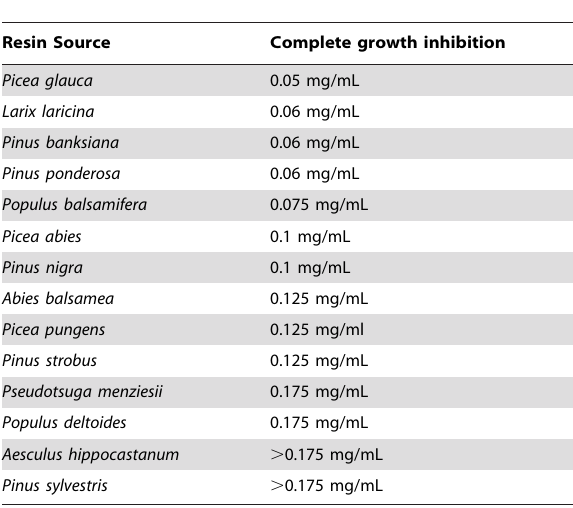
Table 1. Inhibition of pathogen growth by local resins.